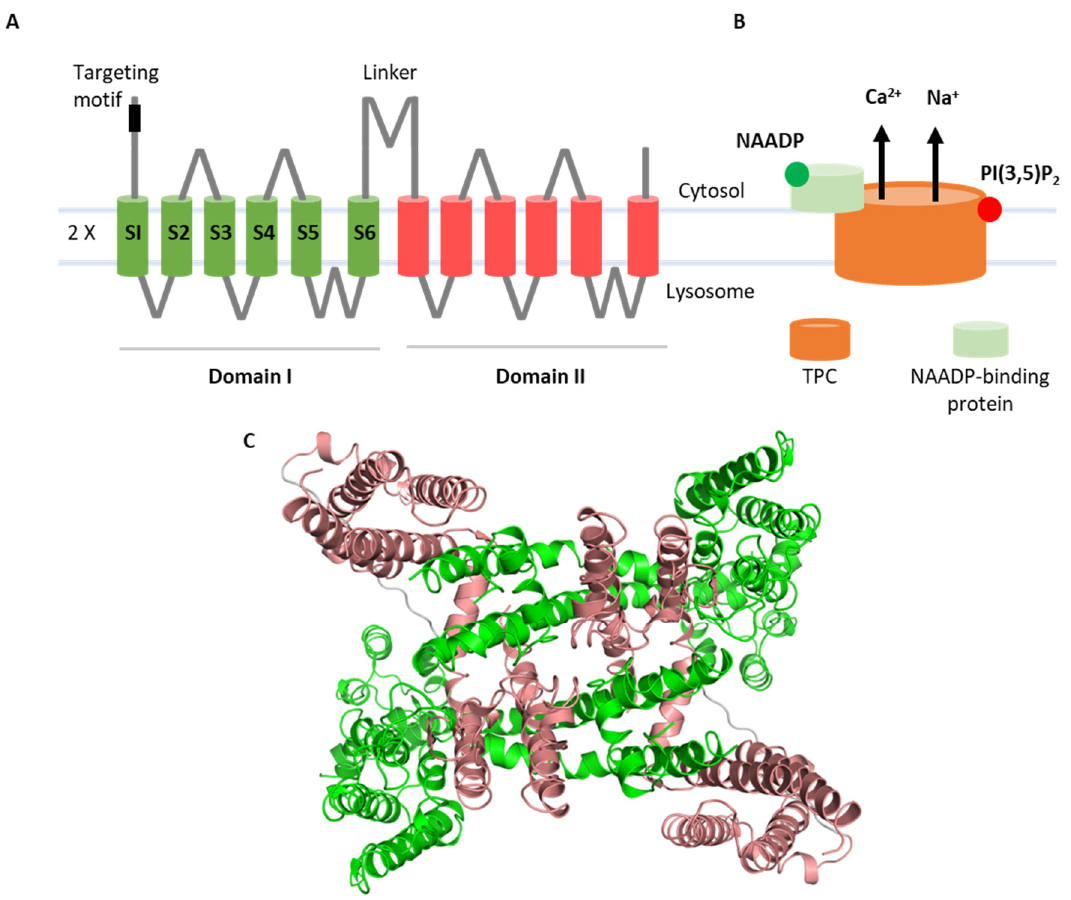
Figure 1. Structure of TPCs. Cartoon illustrations showing domain organization ( A ) and activation scheme ( B ) of TPCs. Cryo-EM structure of TPC2 (PDB: 6nq0) where individual channel domains are color-coded ( C ).